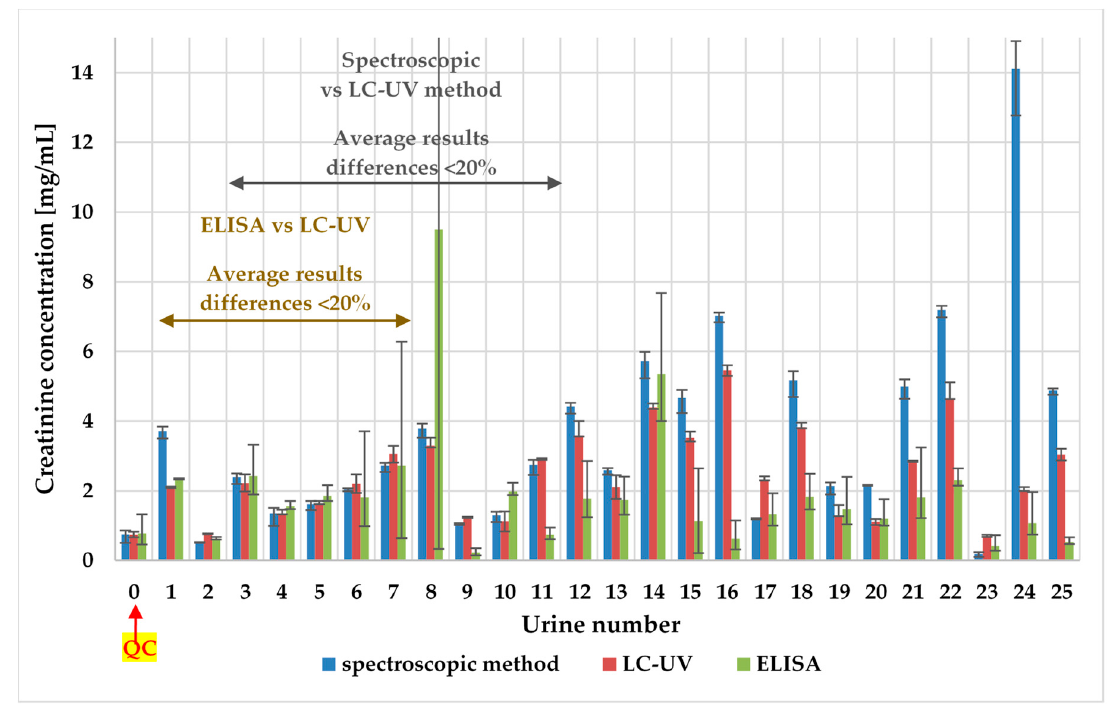
Figure 2. The pig urinary creatinine levels—comparison of spectroscopic, ELISA, and LC-UV method. For every method, the scatter of the results is shown.